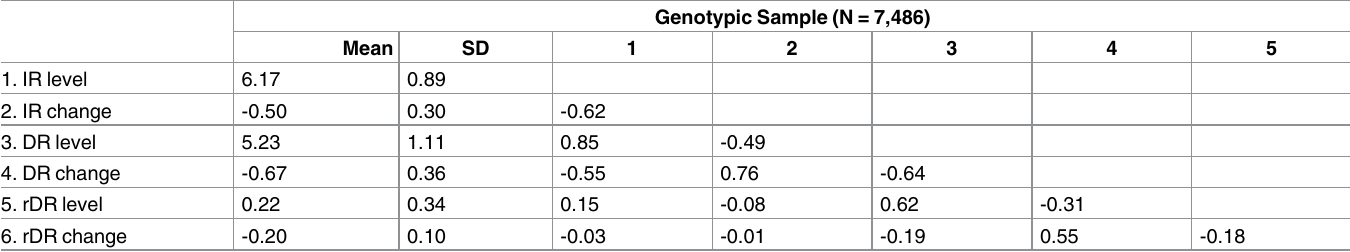
Table 2. Age-adjusted values for estimated immediate recall (IR), delayed recall (DR), and residual delayed recall (rDR) in